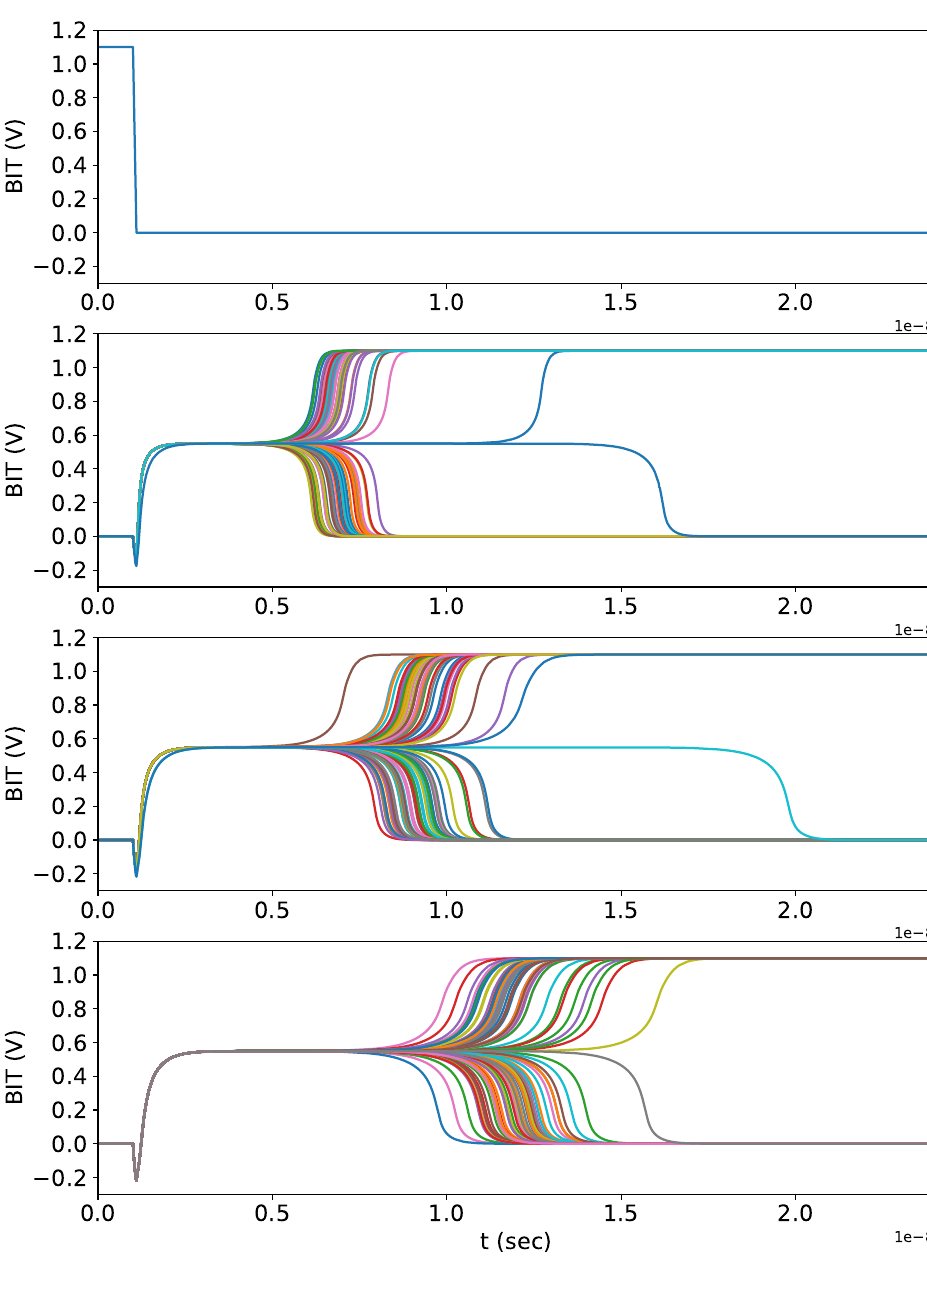
Figure 11. The uniqueness validation of P S